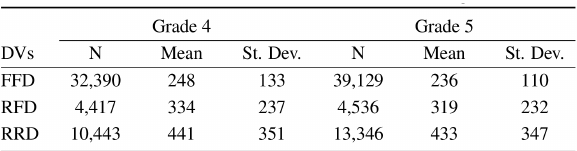
Table 2. Numbers of observations, Means and SDs for the three dependent variables (DVs). Note that FFD = first fixation duration; RFD = re-fixation duration; RRD = rereading